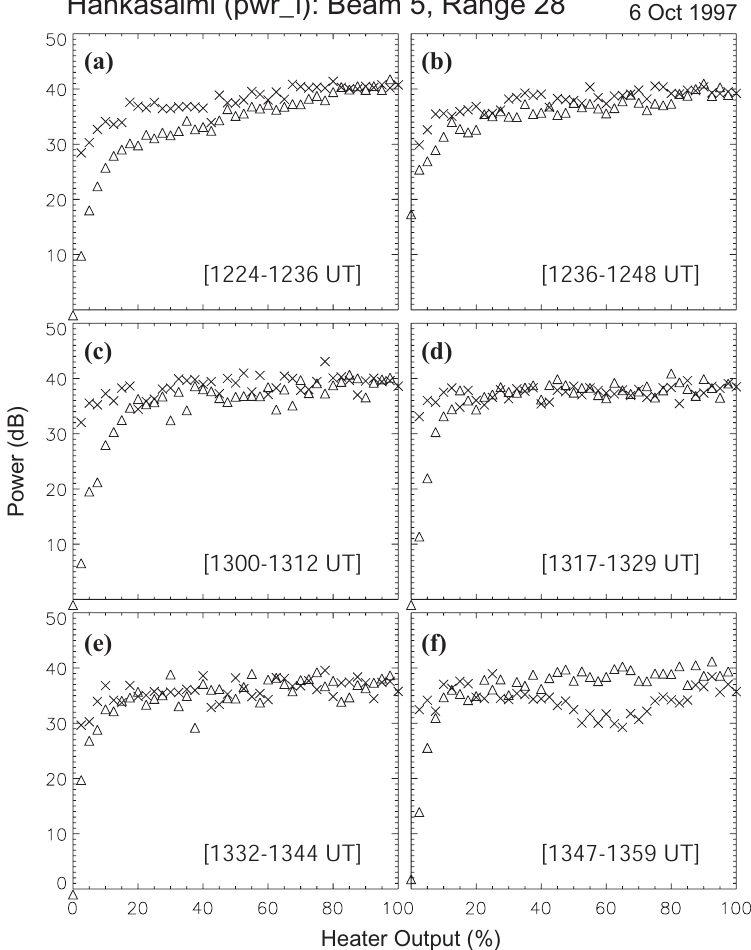
Fig. 5. As for Fig. 4c but for all six cycles (a–f) shown in Fig.